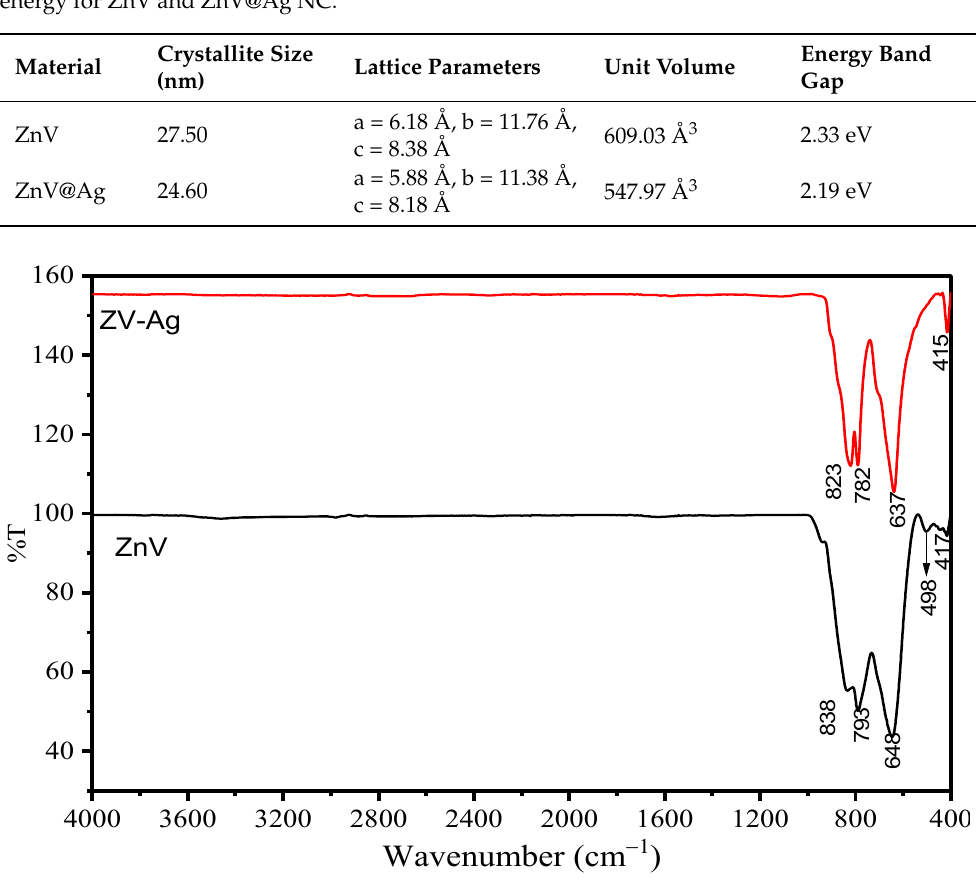
Figure 2. FTIR of ZnV (black line) and ZnV@Ag NC (red line).